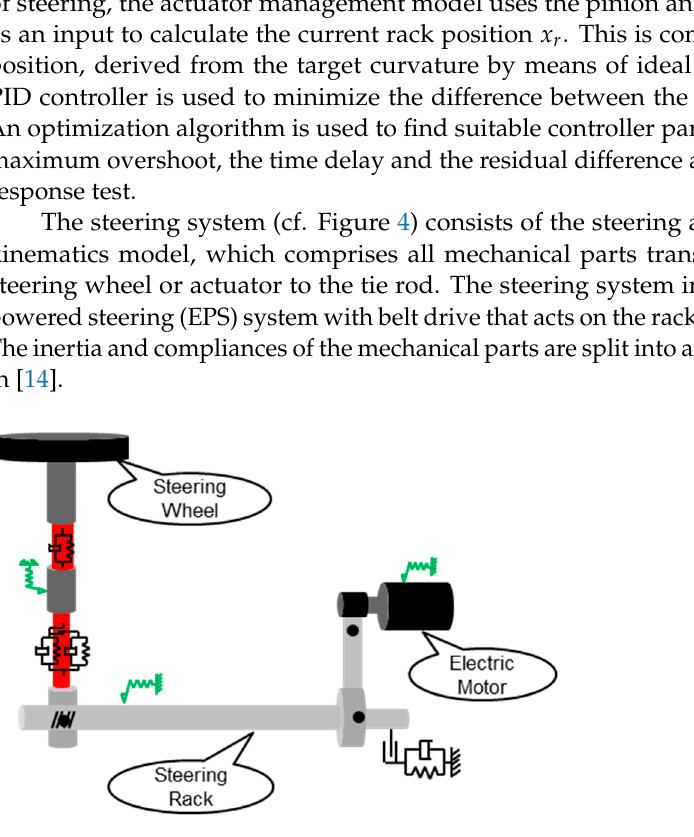
Figure 4. Mechanical system of belt-driven steering system.